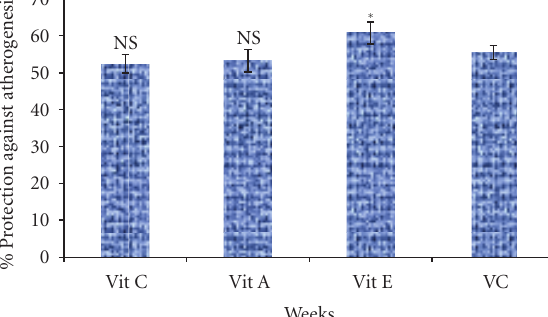
Figure 3: Percentage protection against atherogenesis of supplemented groups. Vit C—salt loaded treated with vitamin C, Vit A—salt loaded treated with vitamin A, Vit E—salt loaded treated with vitamin E, VC—salt loaded treated with vitamins combined. ∗ P < 0.05, and NS—not significant when compared with